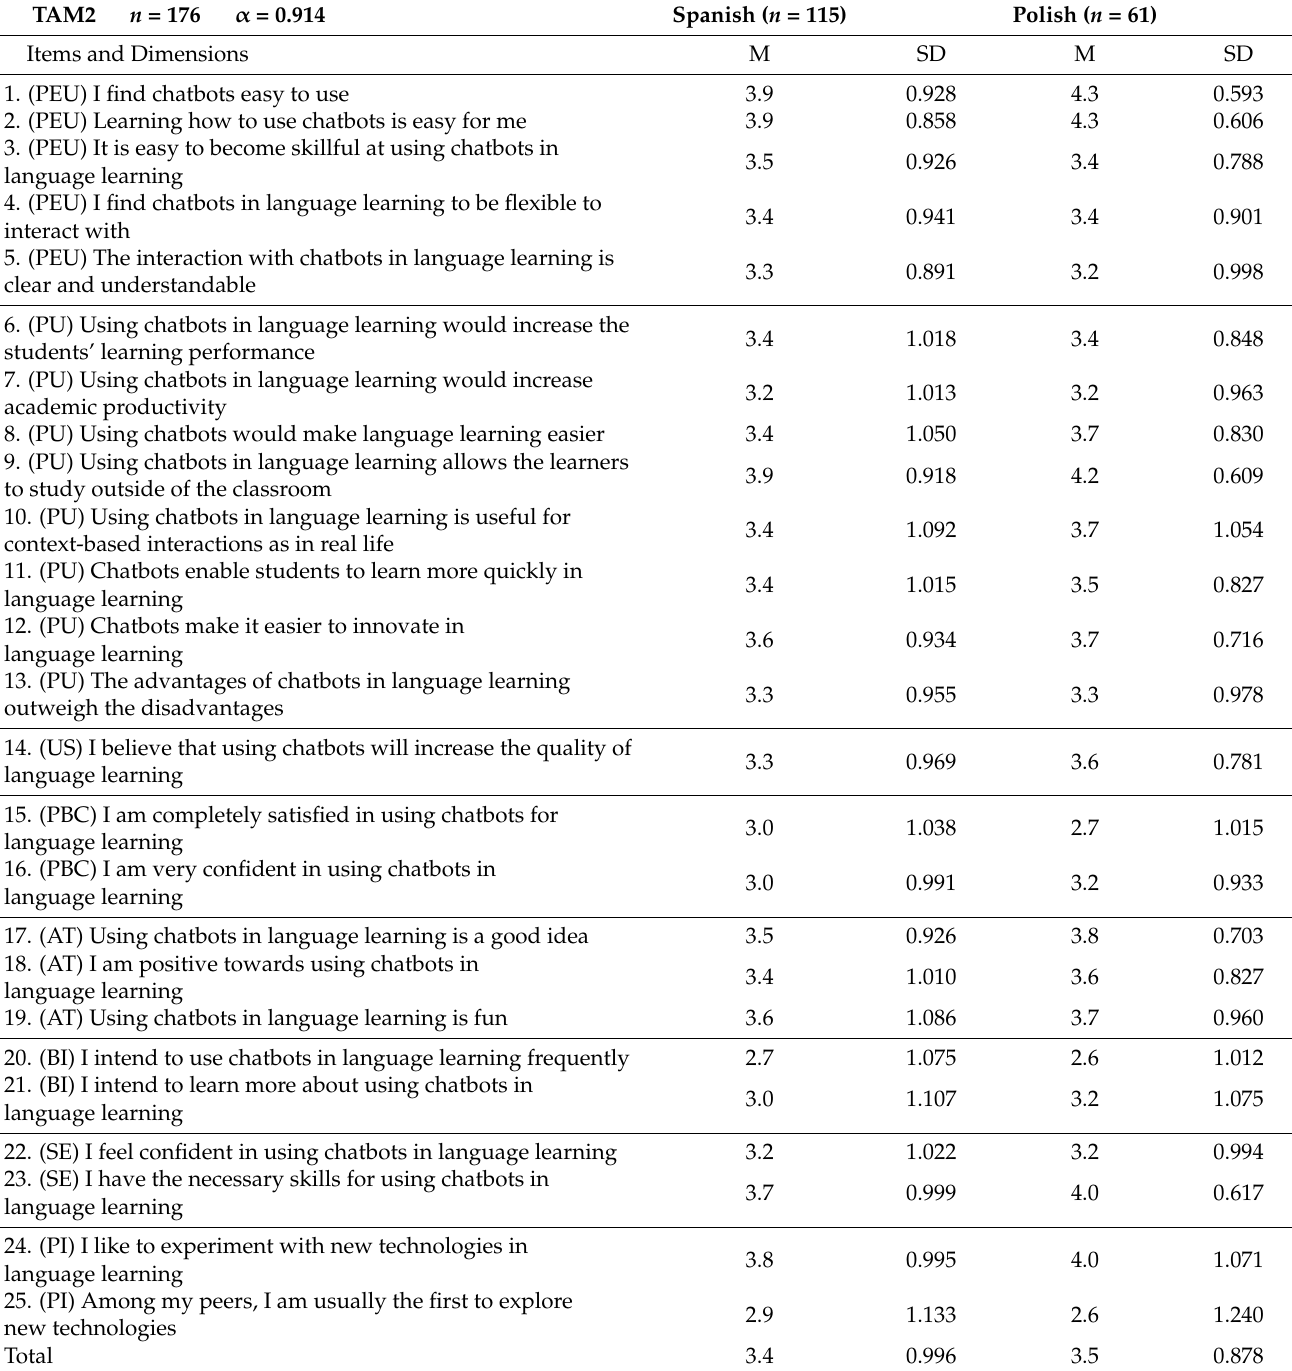
Table 7. Perceptions concerning the use of chatbots in language learning (TAM2 model).